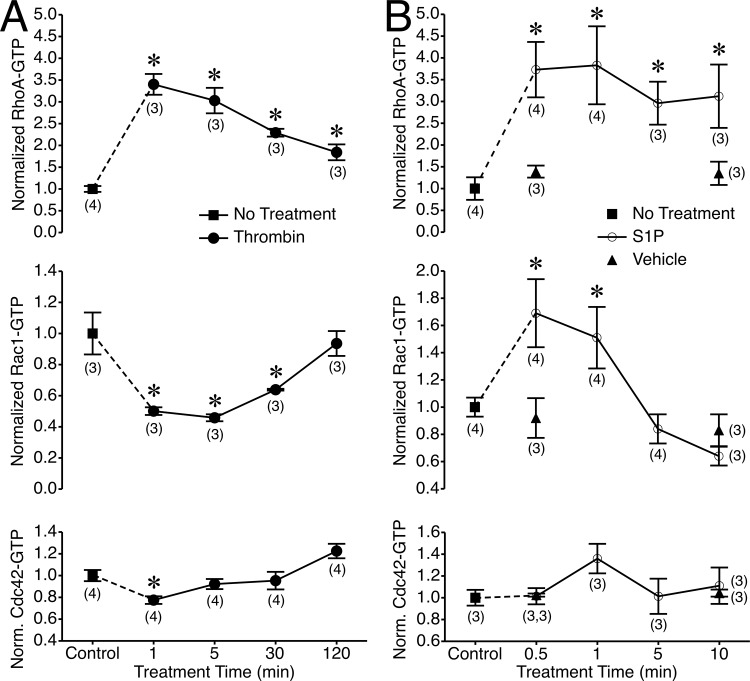
GTP-bound RhoA, Rac1, and Cdc42 levels in response to thrombin and S1P.
A. Impact of thrombin on GTP-bound RhoA, Rac1, and Cdc42 in cultured HUVEC. Untreated cells served as control. B. Impact of S1P on GTP-bound RhoA, Rac1, and Cdc42 in cultured HUVEC. Untreated cells served as control, and vehicle controls were also tested at the 0.5-min and 10-min time points. The numbers in parentheses indicate the number of replicates for each group. *P<0.05 compared to control (no treatment).